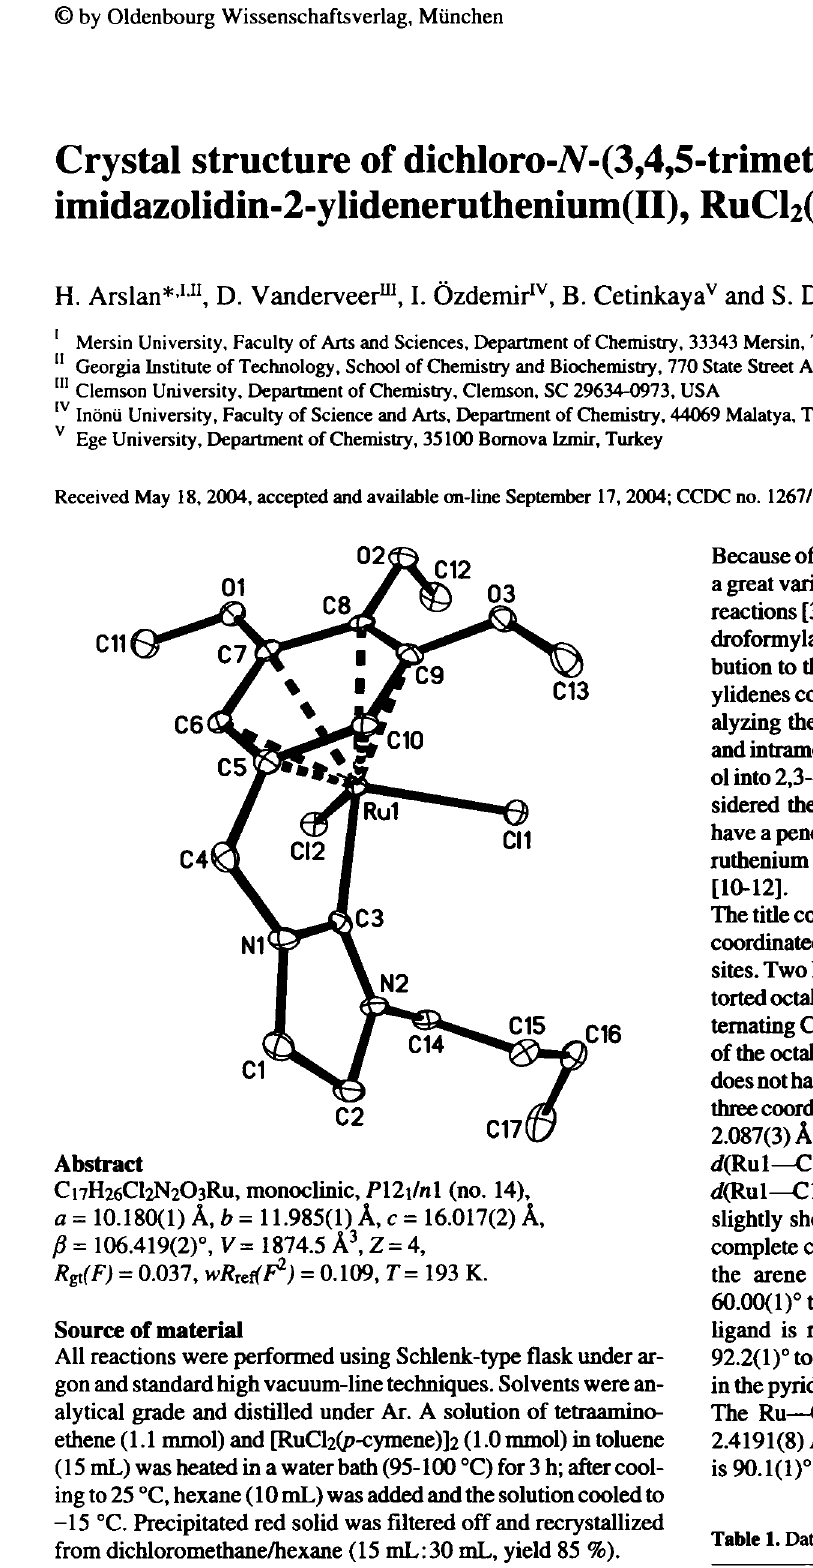
Table 1. Data collection and